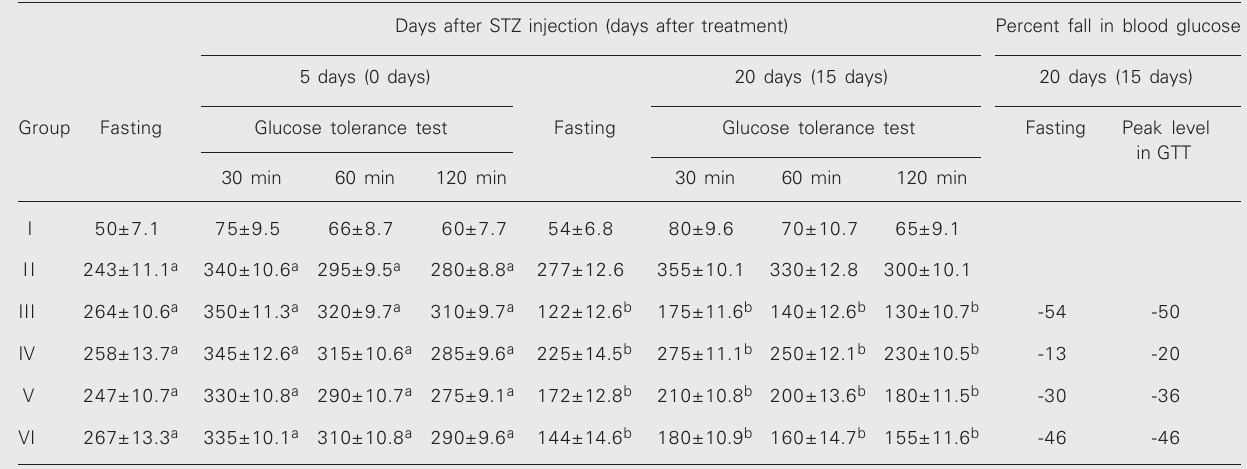
Table 2. Hypoglycemic effect of Eugenia jambolana seed powder on blood glucose (mg/dl) of streptozotocin-diabetic rats.